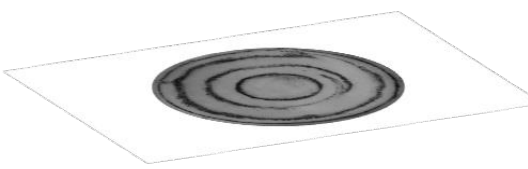
Fig. 4: Example of a slice taken at a height 𝑧 𝑖 = 4 cm after 4 revolutions in the experimental configuration shown in Fig. 1